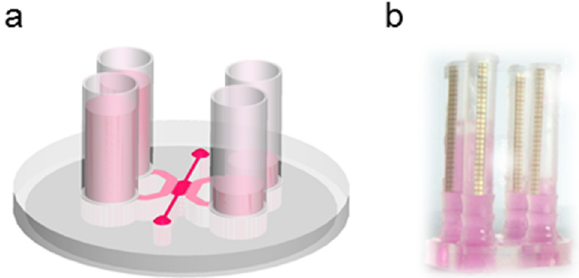
Figure 1. Microfluidic-based experimental set-up for permeability